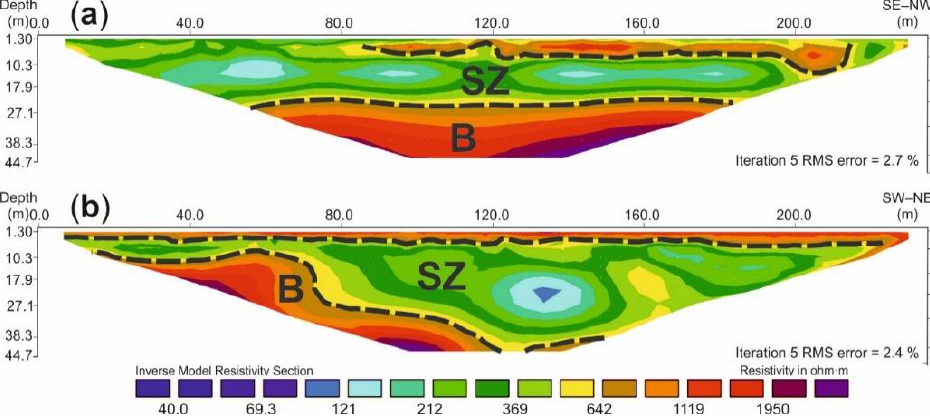
Figure 5. Examples of electrical resistivity tomography (ERT) cross-section results obtained at Port de la Selva site. ( a ) ERT cross-section P8; ( b ) ERT cross-section P1. B: bedrock (aquiclude unit); SZ: Saturated shallow aquifer; black dashed line represents the inferred hydrogeological contact.